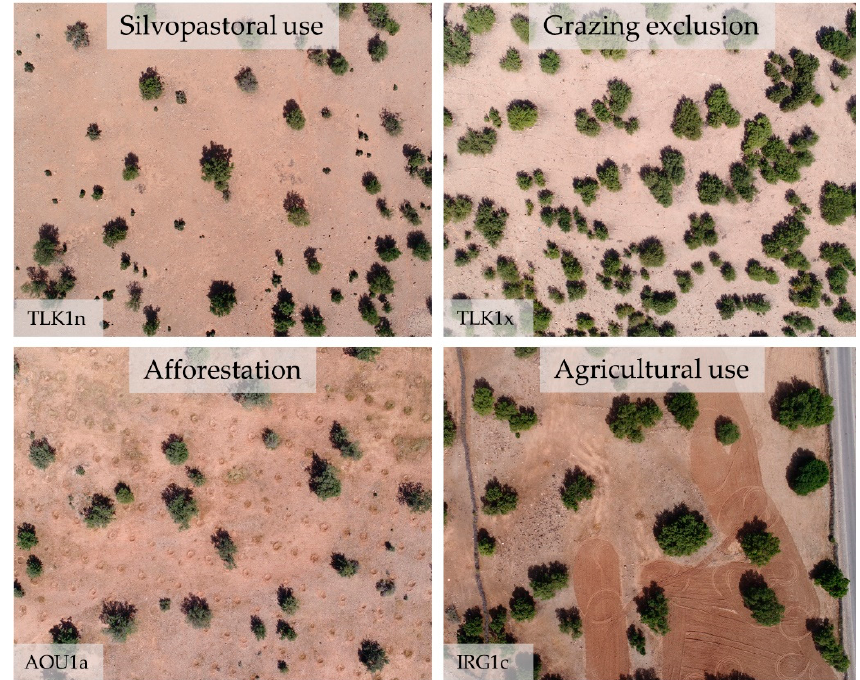
Figure 3. Examples for argan test sites with different land-use/environmental attributes of argan test sites. Vertical small-format aerial photography taken with an unmanned aerial vehicle from a height of Table 1. Test sites, principal attributes, and measurements on test sites (ABA: Aït ben Ali; ABH: Aït